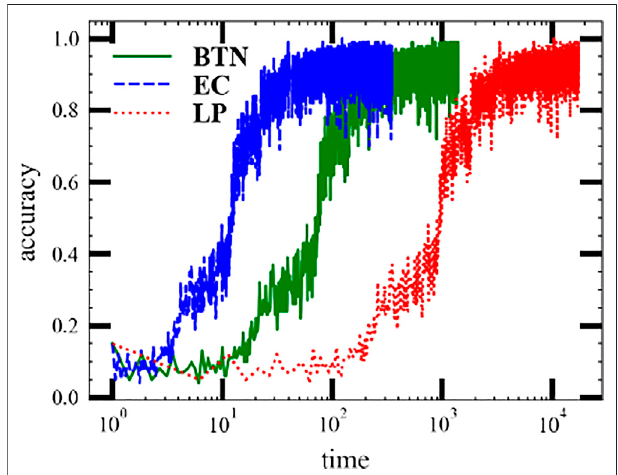
FIGURE9| MemoryrequiredfortheincreasingbatchsizeMPSmachine learning problem. The system is an MPS of L = 21 units, with each unit assigned with V = 50, k = 3, D = 1, O = 10. The green curve ( BTN ) is the requiredmemoryfortheBTNmethod; thebluecurve( EC )istherequired memory for the EC method; and the red curve ( EC * B ) is the B times larger curve of EC .